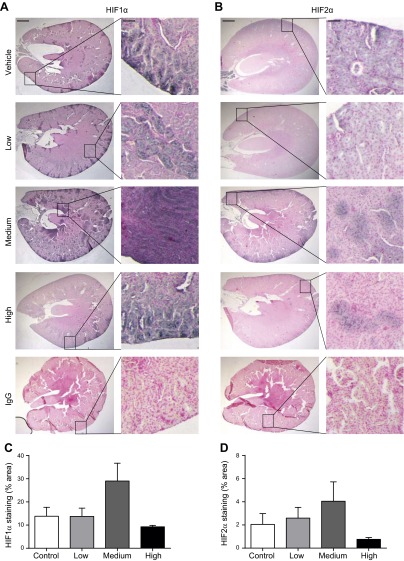
Localization and quantification of HIF1α and HIF2α in kidneys of nitrate-treated rats. A) HIF1α and B) HIF2α staining (black) with nucleated cells (red) in the kidney of treated rats and controls. Images are representative (>3 kidney sections/rat, n = 4–6/group). Scale bars are 2 mm and 50 μm in left and right columns, respectively. C) Quantification of HIF1α and (D) HIF2α staining in the kidney of treated rats and controls (n = 4–6/group). Increases in HIF1α and HIF2α staining between controls and rats receiving the medium treatment dose did not reach statistical significance (P = 0.066 and P = 0.29, respectively).